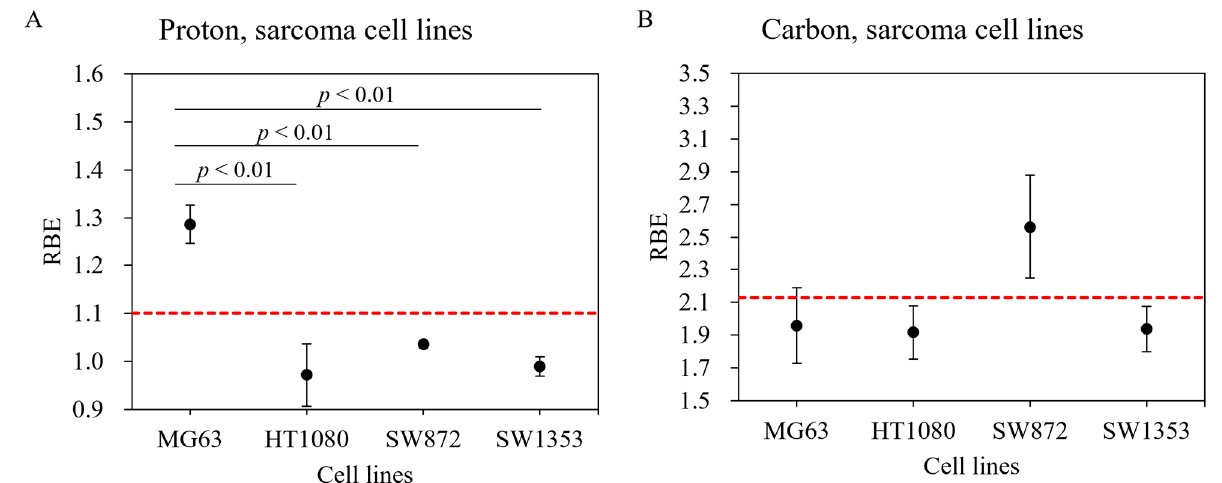
Figure 2. Relative biological effectiveness (RBE) of various human sarcoma cell lines exposed to proton beam and carbon-ion irradiations. Human sarcoma cell lines irradiated with ( A ) proton beam and ( B ) carbon ions. Bars represent confidence intervals of one standard deviation. The red dashed line indicates RBE values of 1.1 for proton beam and 2.13 for carbon-ion irradiations.